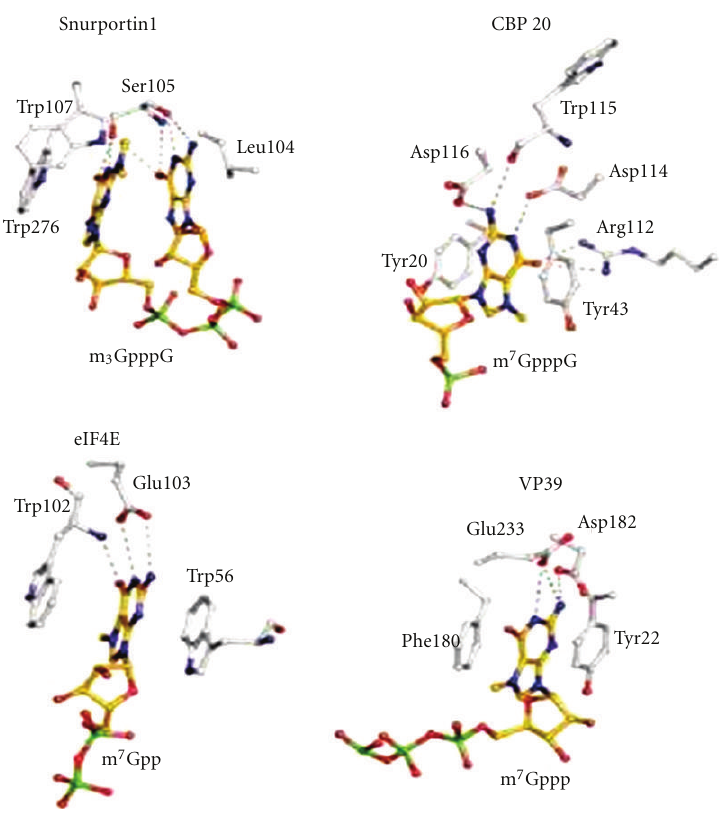
Figure 36: The comparison between m 32,2,7 G binding mode to snurportin1 and m 7 G cap binding mode to CBP 20, eIF4E and VP39 [91]. The m 32,2,7 G is stacked between tryptophan 107 and penultimate nucleotide G of cap core m 32,2,7 GpppG.